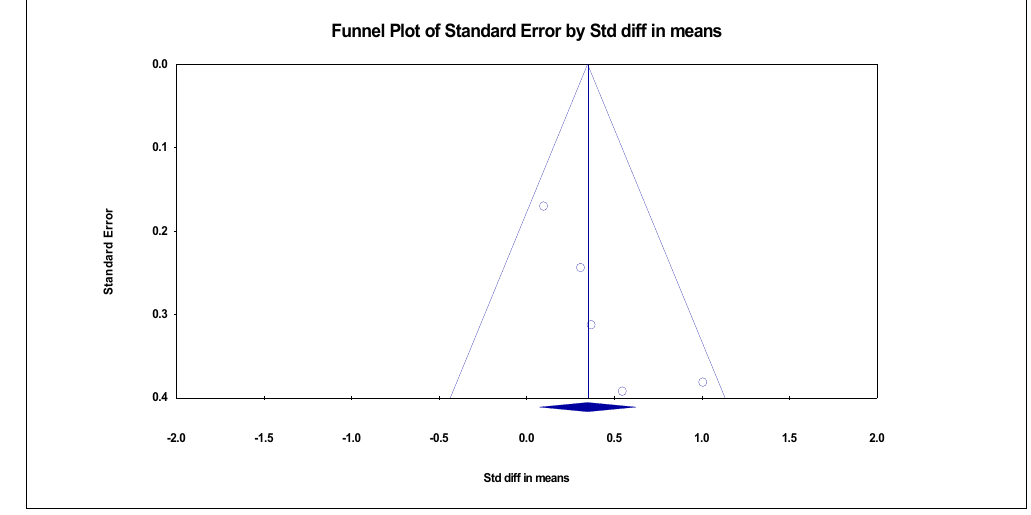
Figure 3. Funnel plot of BDI ‐ II effect of MBCT on depression.